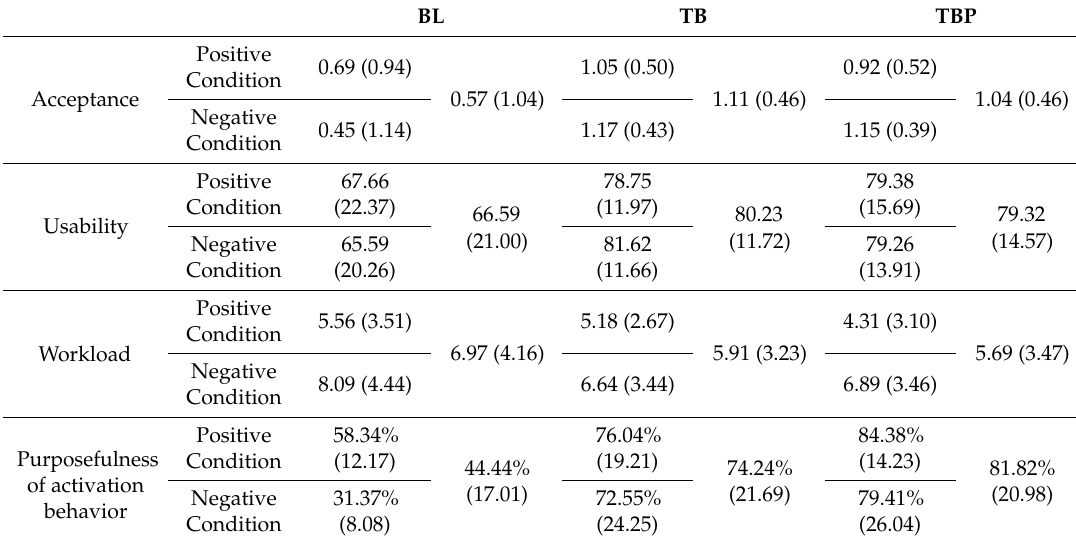
Table 2. Means and standard deviations M ( SD ) for acceptance, usability, workload, and purposefulness of activation